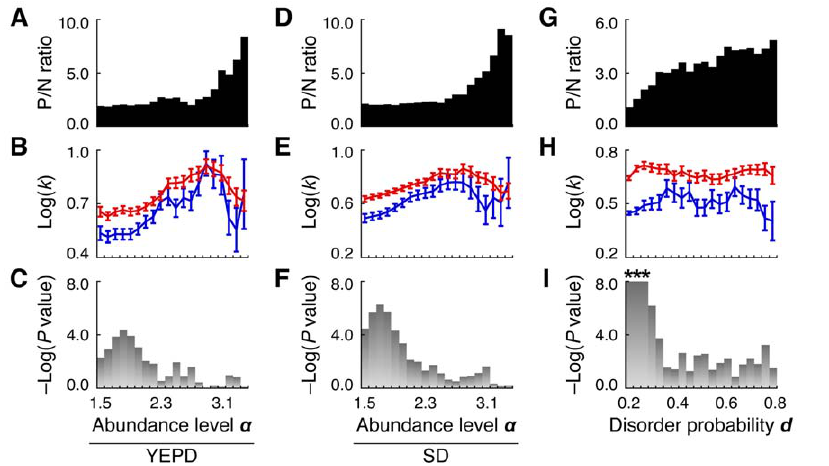
Figure 4. Difference between node degree levels of phosphoproteins and nonphosphoproteins at each level of protein abundance (A–F) and protein disorder (G–I). ( A–C ) YEPD, protein abundance dataset for cells grown in rich medium; ( D–F ) SD, protein abundance dataset for cells grown in synthetic complete medium. Protein abundance provided in the original dataset [37] was log-transformed (base 10) as abundance level a . The type of phospho-PPI network is ‘‘ALL’’ (for each analysis, protein nodes for which abundance or disorder levels and their corresponding edges were not provided were eliminated from the phospho-PPI network). Each bin corresponds to the protein abundance level between a (indicated on the horizontal axis) and a + 0.5 ( A–F ) or the protein disorder probability between d (indicated on the horizontal axis) and d + 0.2 ( G–I ). For protein nodes corresponding to each bin, the P to N (P/N) ratio of protein number count (where P and N are number counts of phosphoproteins and nonphosphoproteins) ( A,D,G ), average node degree levels [Log( k ) (base 10)] of phosphoproteins (red line) and nonphosphoproteins (blue line) ( B,E,H ), and statistical significance [ 2 Log( P value) (base 10)] of differences between Log( k ) of phosphoproteins and nonphosphoproteins ( C,F,I ) are represented. Error bars denote s.e.m. Asterisks denote 2 Log( P value) . 8.0 (i.e. P , 10 2 8